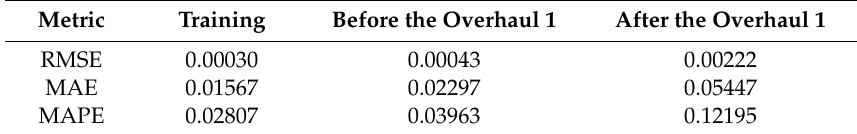
Table 5. Artificial Neural Network (ANN) algorithm results for the regression problem (with 20 N/HL). Metric Training Before the Overhaul 1 After the Overhaul 1